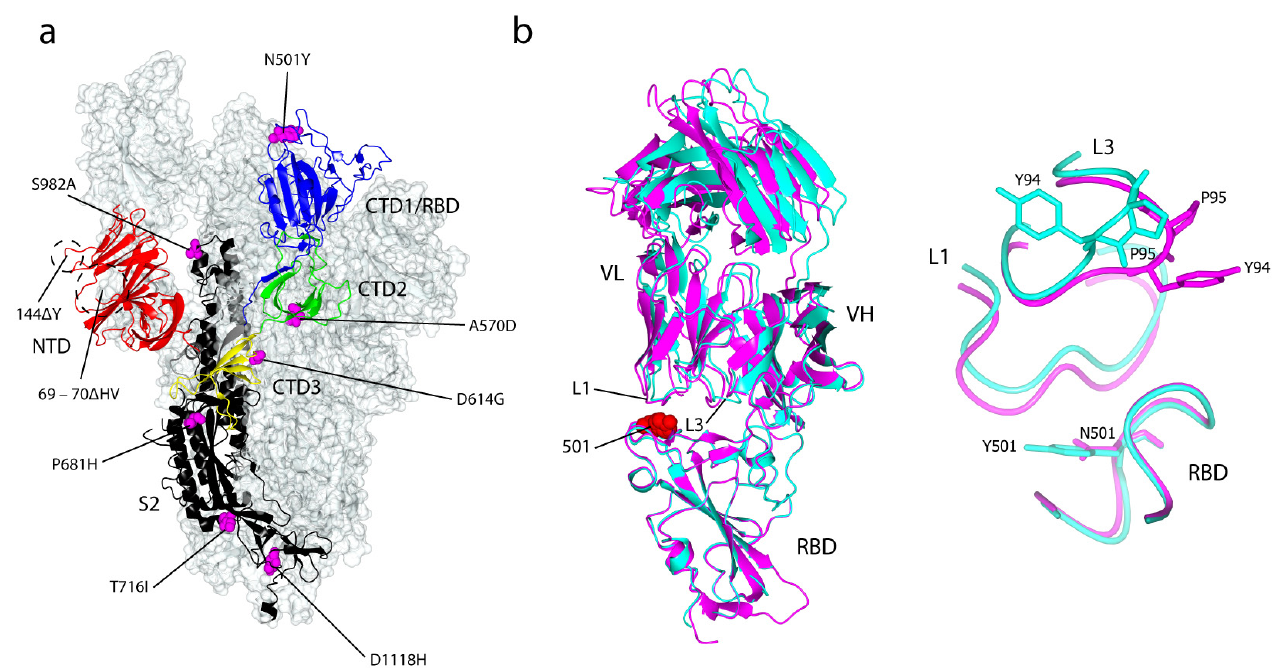
Figure 4. Location of B.1.17 variant mutations antibody recognition of the SARS-CoV-2 S glycoprotein. ( a ) The locations of seven substitutions and two deletion mutations within the UK B.1.1.7 SARS-CoV-2 S glycoprotein at 3.22 Å (PDB: 7LWU) [54]. Only one mutation: N501Y, lies within the RBD and two deletions: 69–70 ∆ HV and 144 ∆ Y are within the NTD of the S protein. The D614G mutation presents in all B.1 lineages. ( b ) Left: the superimposition of the N501 RBD/Fab 269 complex (magenta; PDB: 7NEH) onto the Y501 RBD/Fab 269 complex (cyan; PDB: 7NEG) [52]. The location of residue 501 is shown, which in contact with the L1 and L3 loops of Fab 269. Right: an apparent displacement of the L1 loop and concomitant effect on the L3 loop, caused by the mutation of Asn to Tyr at position 501.